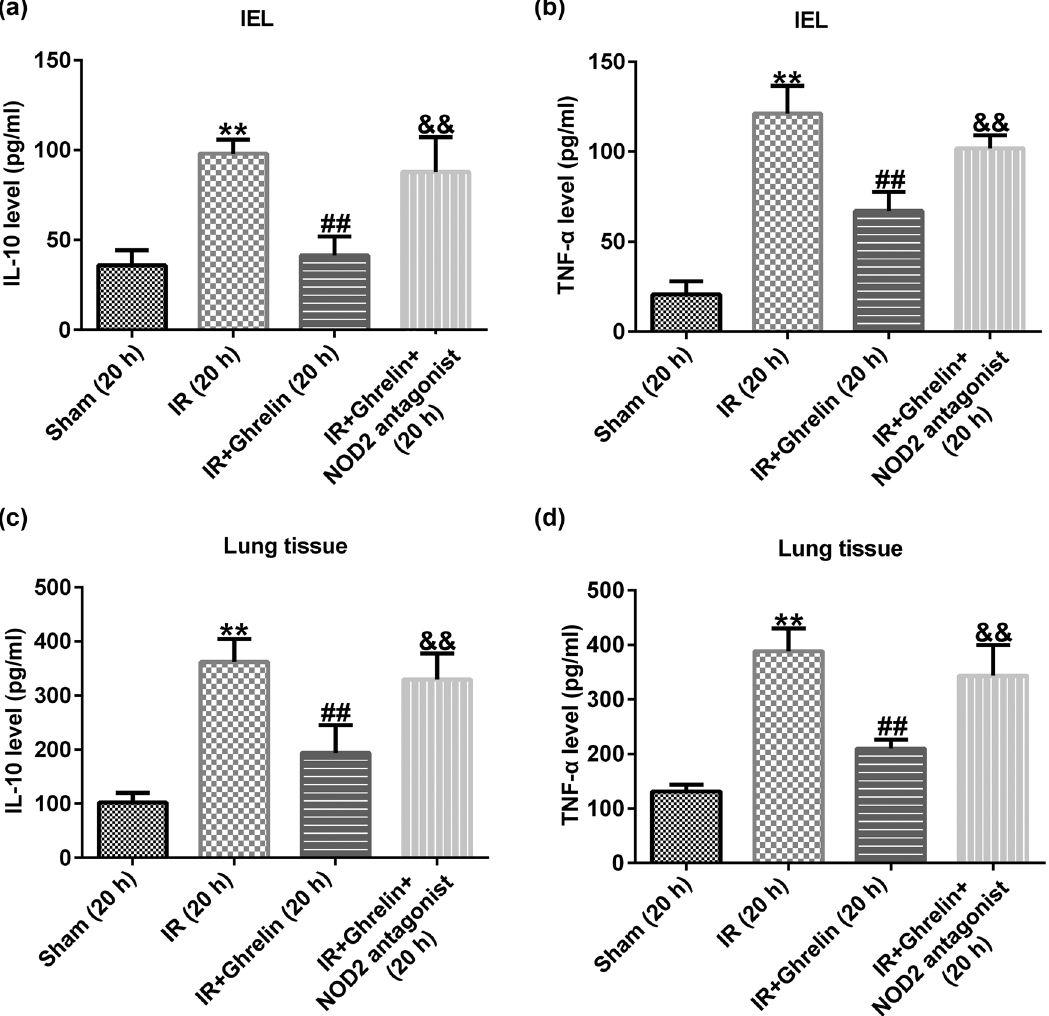
Figure 4: NOD2 antagonist reversed the e ff ects of ghrelin on the release of in fl ammatory factors in IEL cells and lung tissue. Pro - in fl am - matory cytokine levels in IEL cells and lung tissue were evaluated using an ELISA. Changes were observed in the levels of IL - 10 ( a and c ) and TNF - α ( b and d ) in IEL cells and lung tissue in the sham, I/R injury, ghrelin, and ghrelin and NOD2 antagonist groups after reperfusion. Data were expressed as mean ± SD, n = 6; ** P < 0.01 vs sham; ## P < 0.01 vs IR; and P < 0.01 vs IR +